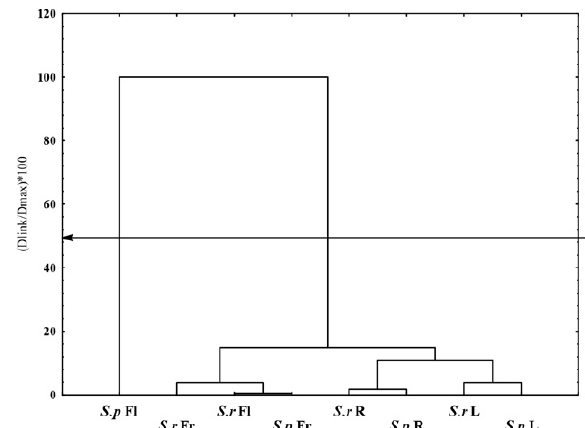
Figure 3. Dendrogram of the microelements content (Al, B, Ba, V, Co, Fe, Cu, Mn, and Zn) in the leaf, flower, fruit, and root of plant species S. rigidum and S. pallasii